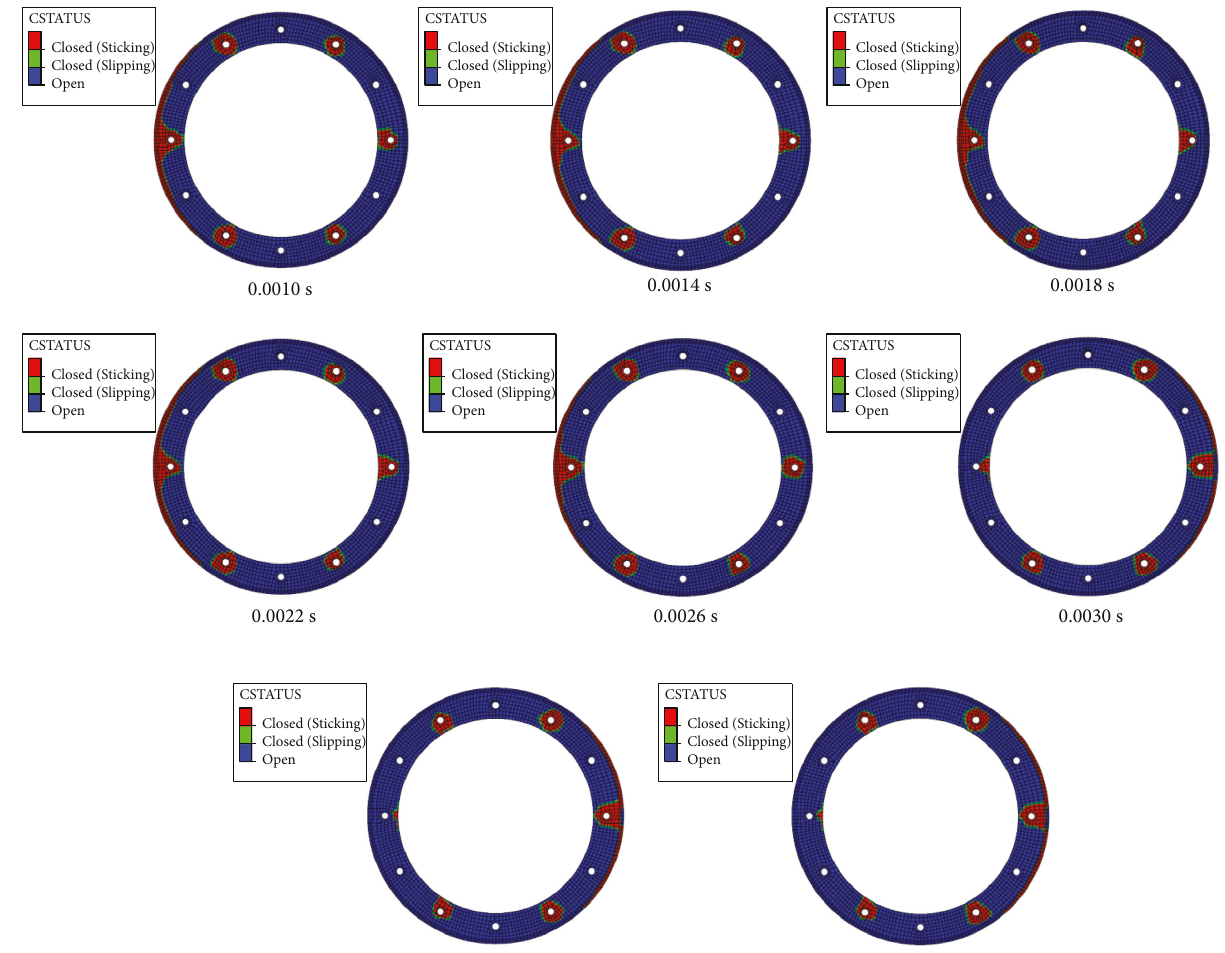
Figure 16: Time-varying diagram of the contact state of the connecting surface during the impact (6 bolts’ flange structure with one bolt loosened to 300N under 1.5kN impact load on the